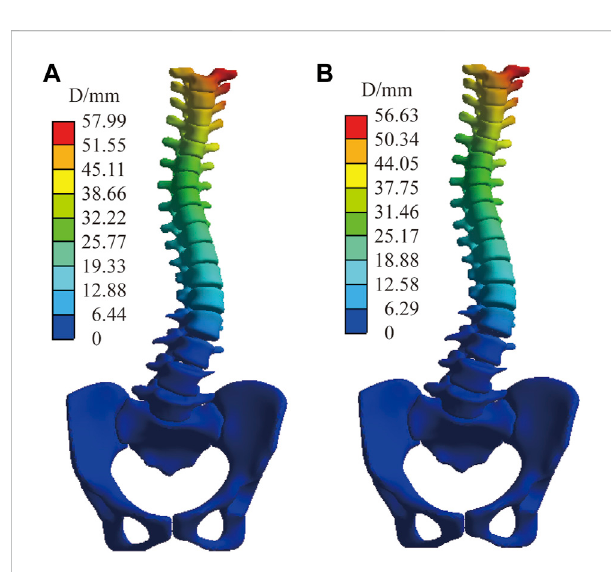
in fl uence the thoracic more than the lumbar, while sagittal force signi fi cantly impacts the Lordosis and Kyphosis angle. These fi ndings are also supported by Karimi et al. (2020) and the Chêneau-type brace design principle (Rigo and Jelacic, 2017). A